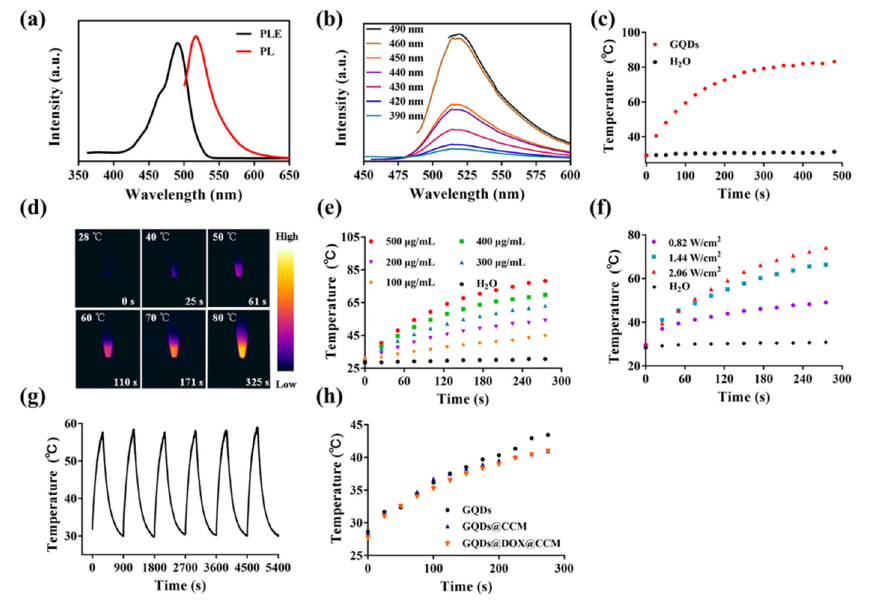
Figure 2. Characterization of GQDs. ( a ) PL and excitation (PLE) spectra of GQDs. ( b ) PL spectra of GQDs excited at different wavelengths varied from 390 to 490 nm. ( c , d ) The temperature change of the GQDs solution (500 µ g/mL) under NIR laser irradiation (808 nm, 1.44 W/cm 2 ) for 8 min. ( e ) The temperature change of the GQDs solution under NIR laser irradiation (808 nm, 1.44 W/cm 2 ) with different concentrations for 5 min. ( f ) The temperature change of the GQDs solution of 300 µ g/mL under 808 nm laser irradiation with different power for 5 min. ( g ) The photostability of GQDs of 200 µ g/mL under NIR laser irradiation (808 nm, 1.44 W/cm 2 ). ( h ) The temperature change of GQDs, GQDs@CCM, and GQDs/DOX@CCM solutions under NIR laser irradiation (808 nm, 1.44 W/cm 2 ), and the GQDs concentration in all groups was 100 µ